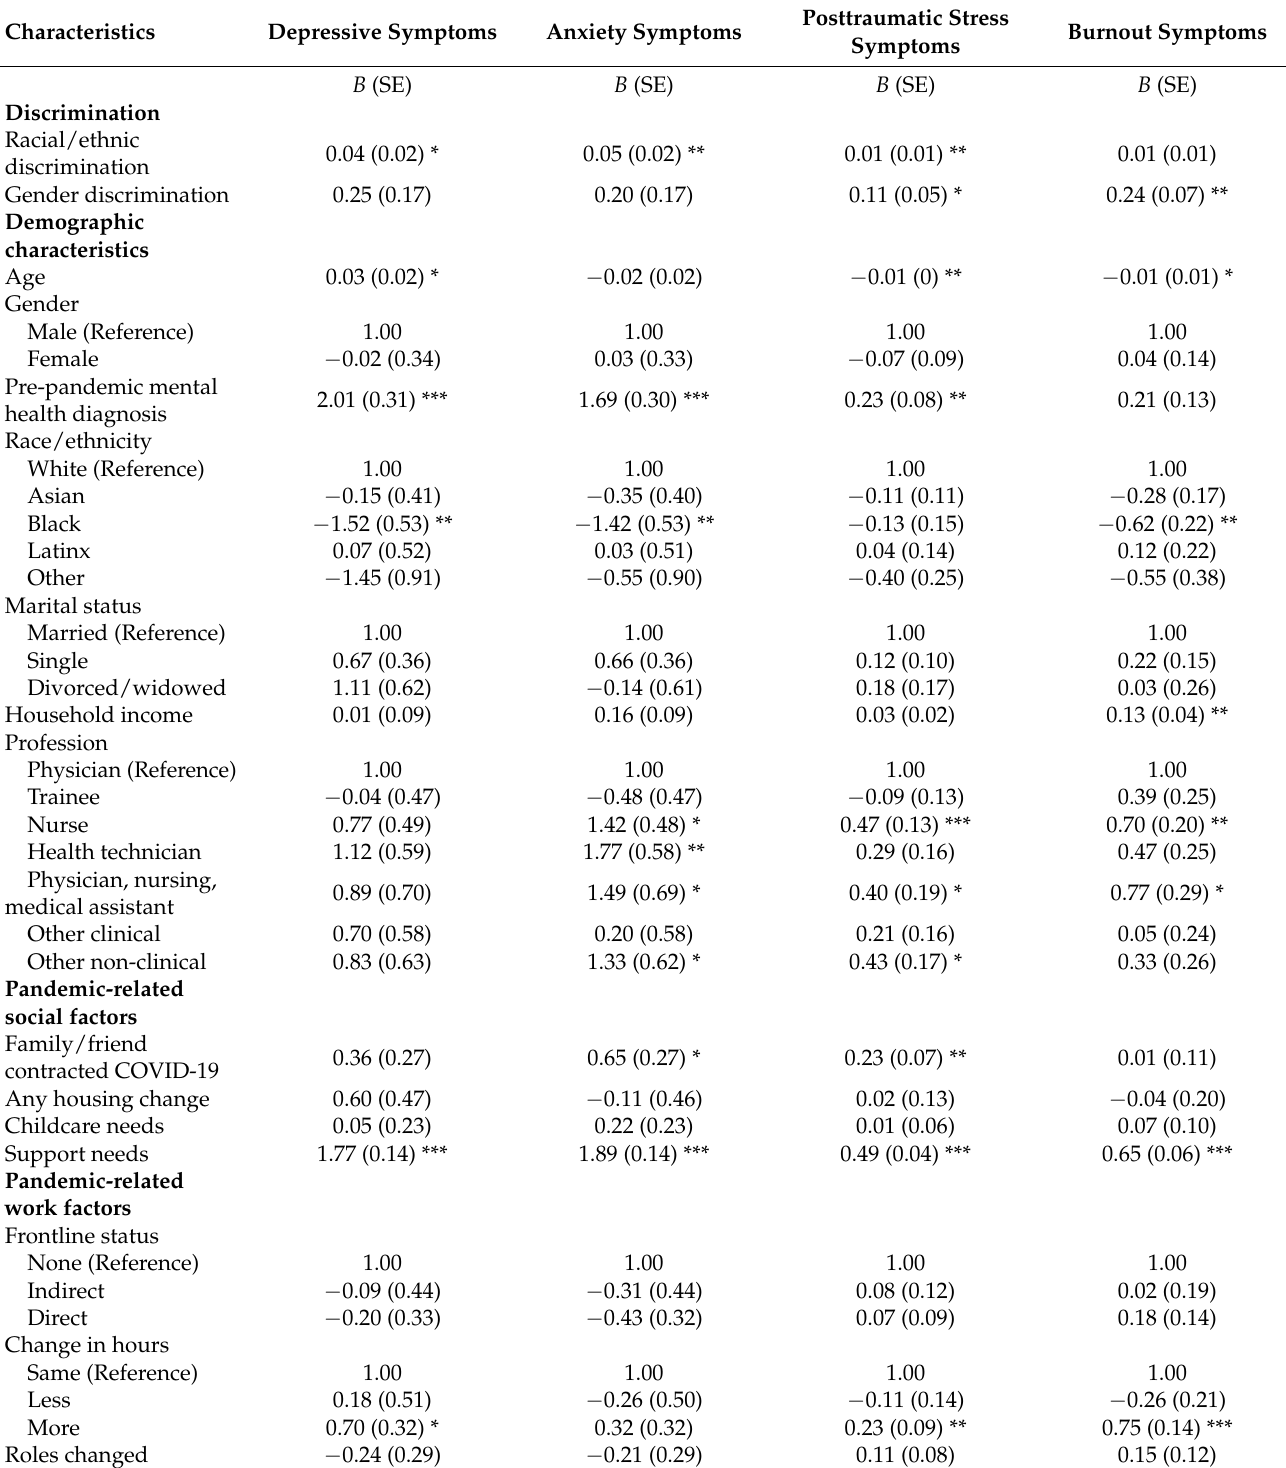
Table 3. Adjusted linear regression models for discrimination and mental